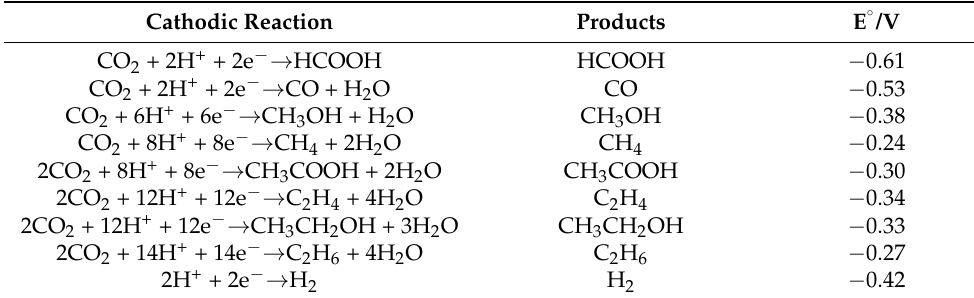
Table 1. Reaction mechanism of electrocatalytic CO 2